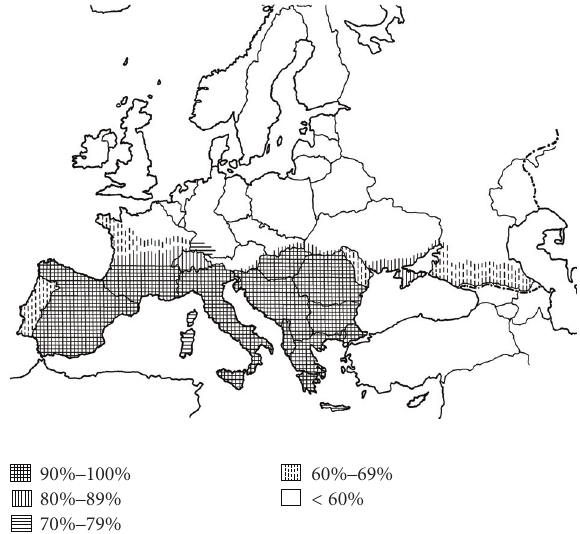
Figure 8: Prediction of potential Bhanja virus area in Europe, based on proportion of the bioindicator species present in particular countries and area